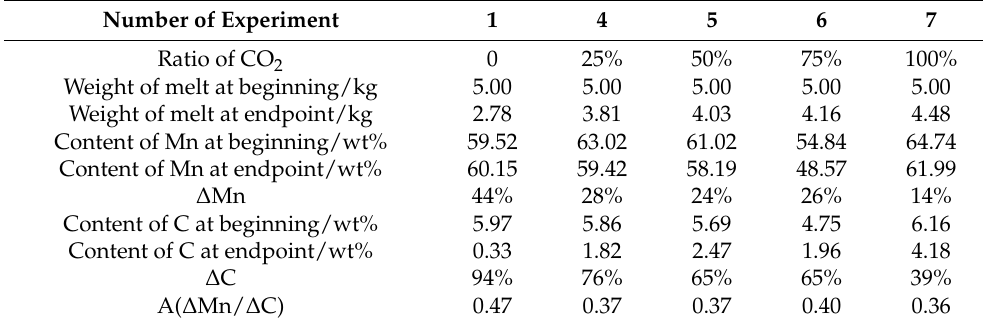
Table 5. Degree of manganese loss ( ∆ Mn) and decarburization ( ∆ C) in the melt, as well as A ( ∆ Mn/ ∆ C), at the start and endpoint of the different